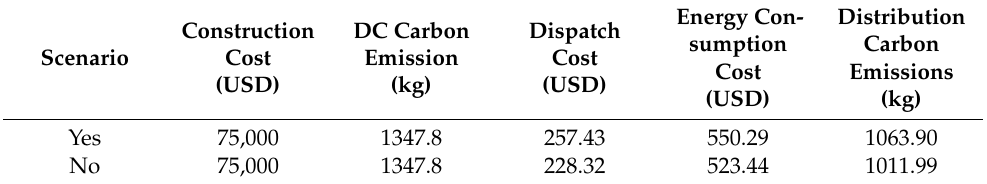
Table 8. Comparison of carbon emissions considering traffic congestion or not in the case of cargo splitting.